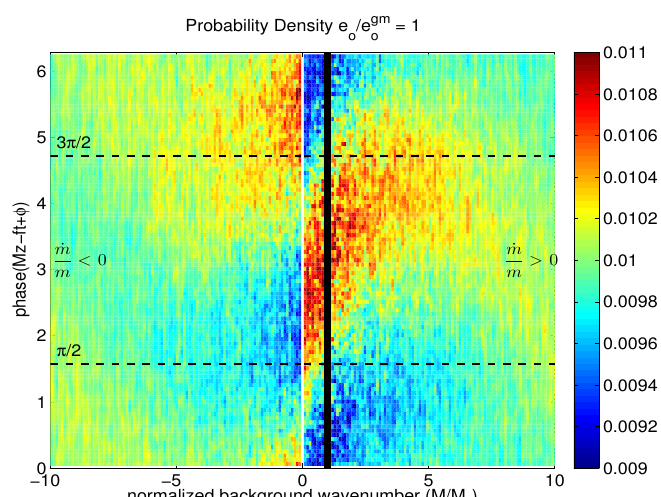
Figure 6. Probability density of a test wave with vertical wavenumber m = m o ± δ residing in the background phase ϑ i = M i z − ft + φ i as a function of background wavenumber M i . The three vertical black lines denote the approximate resonance condition C ph = C z g and the inertial members of the two triads that m o participates in. Upper, middle, lower panels are 10 − 2 e o (10 − 1 e o , 10 0 e o ).